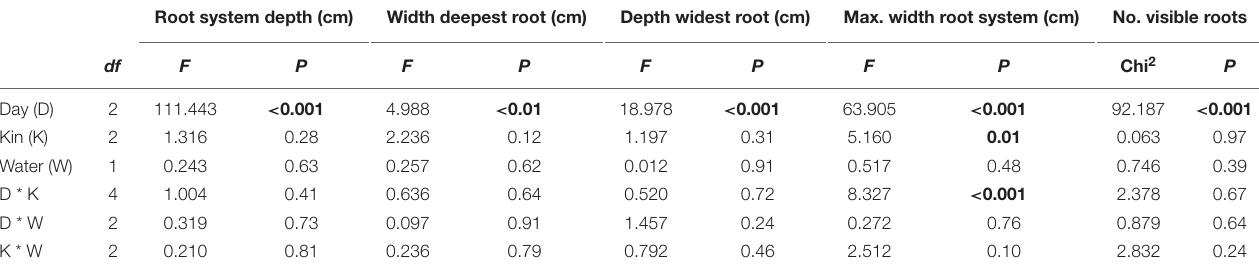
TABLE 1 | ANOVA table of mixed-effects model testing the influence of day, water treatment, kin and their 2-way interactions on Glechoma hederacea root parameters measured in Experiment 1. Root system depth (cm) Width deepest root (cm) Depth widest root (cm) Max. width root system (cm) No. visible roots